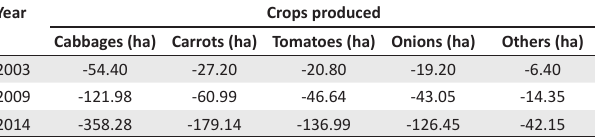
TABLE 2: Changes in agricultural farm areas on vegetable crops basis. Year Crops produced Cabbages (ha) Carrots (ha) Tomatoes (ha) Onions (ha)